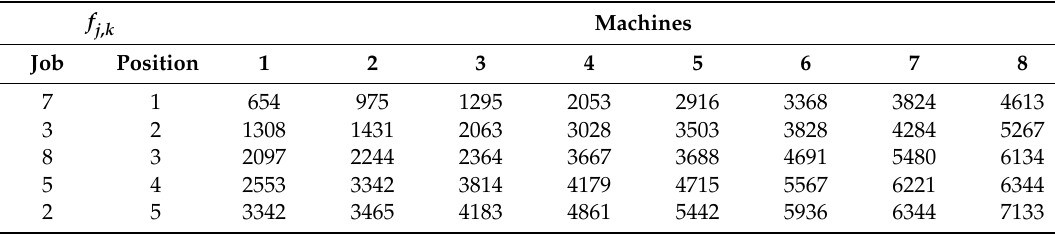
Table A3. Completion times of heads for { 7,3,8,5,2 } with C max =